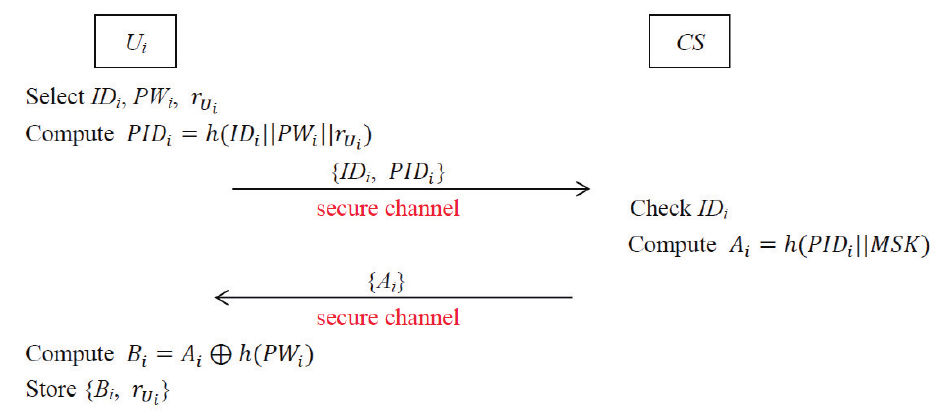
Figure 3. Registration procedure of